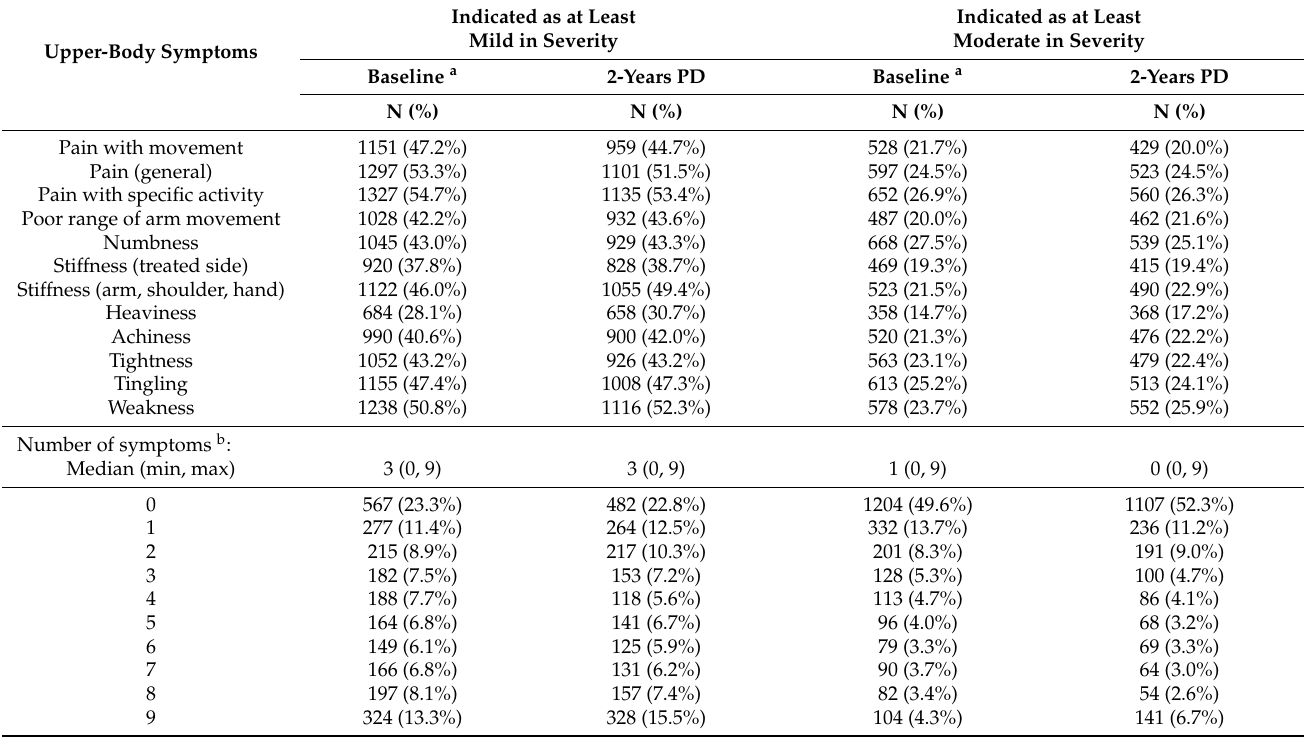
Table 2. Upper-body symptoms reported by participants of the Carolina Breast Cancer Study, Phase III at baseline a and 2-years post-breast cancer diagnosis